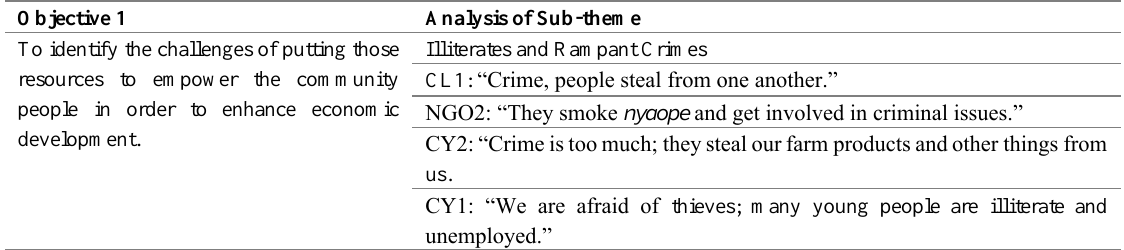
Table 2: Thematic representation of data based on the research objective 2